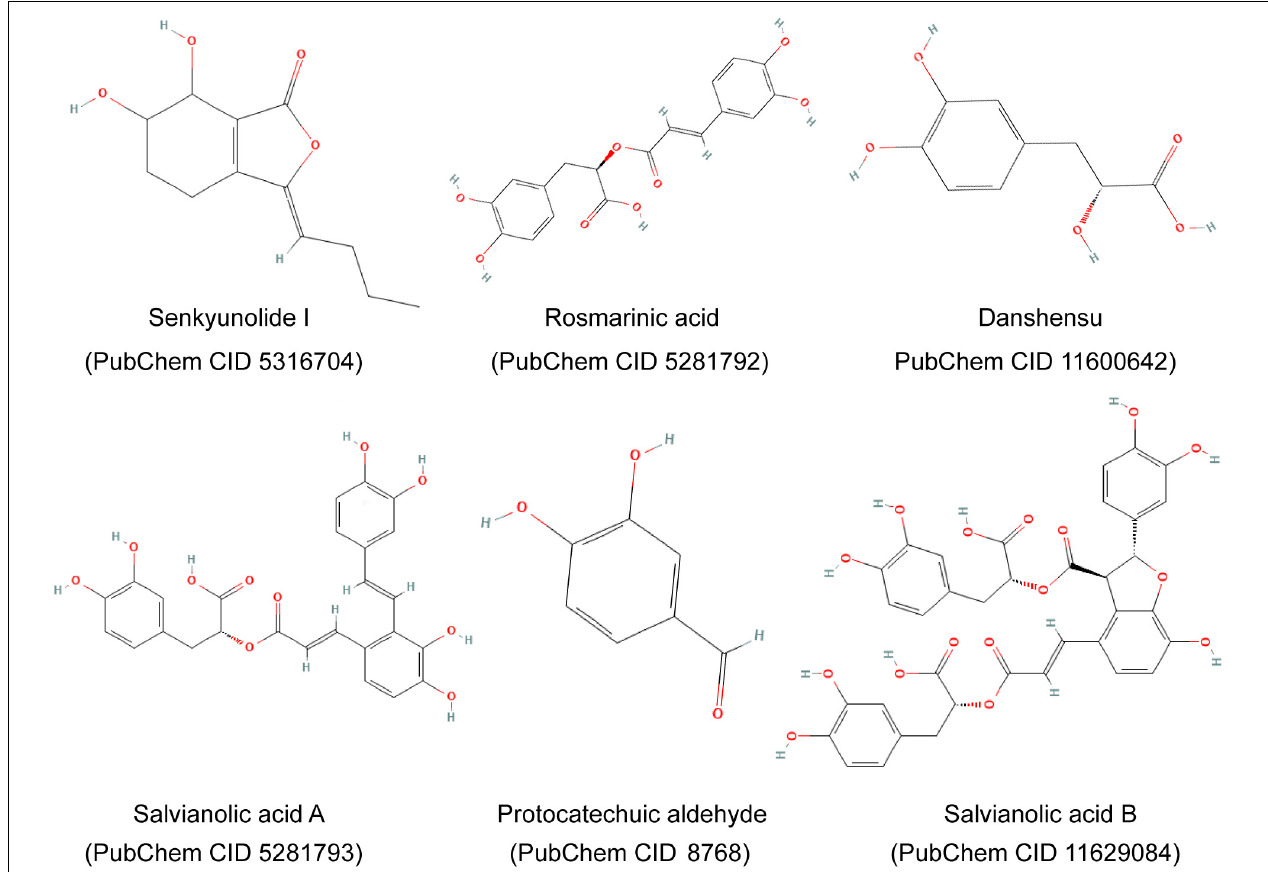
FIGURE 2 | Major components and chemical structures of extracts of Salvia miltiorrhiza Bge. and Ligusticum chuanxiong Hort. (Guanxinning